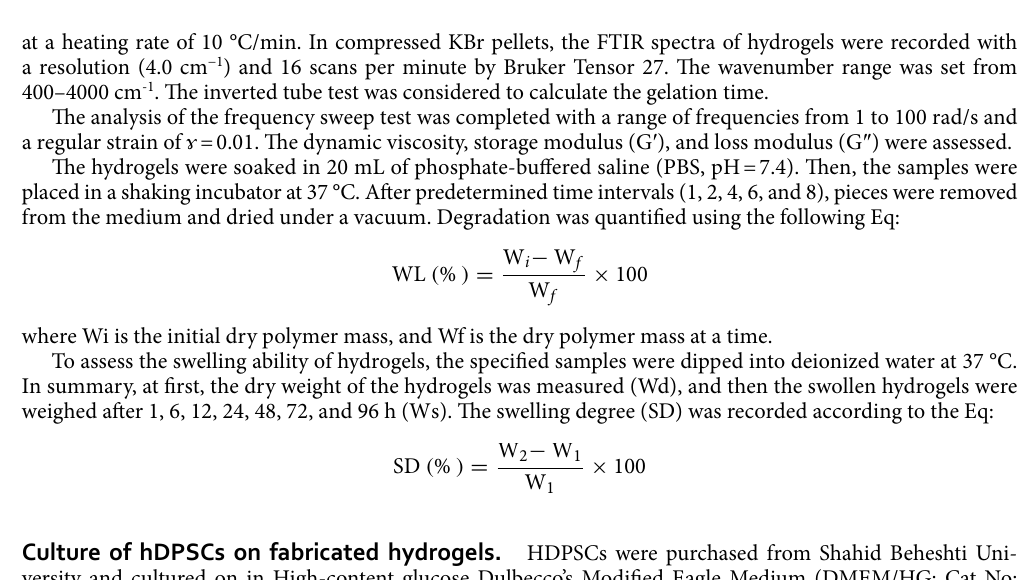
Figure 11. ( A) Injectable ADCNCs/SF/PEEK hydrogel. ( B ) Critical size bone defect (8 mm) in rat cranial ( C) ADCNCs/SF/PEEK hydrogel in created defect ( D) Incision